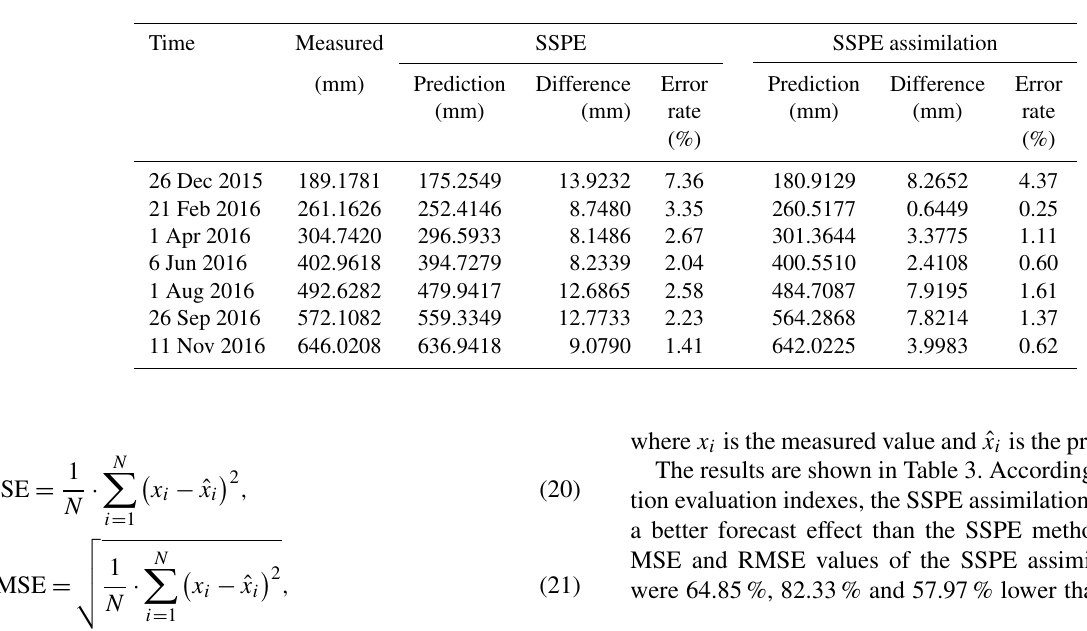
Table 2. Comparison between the predicted values of cumulative displacement and measured displacement using different methods in station